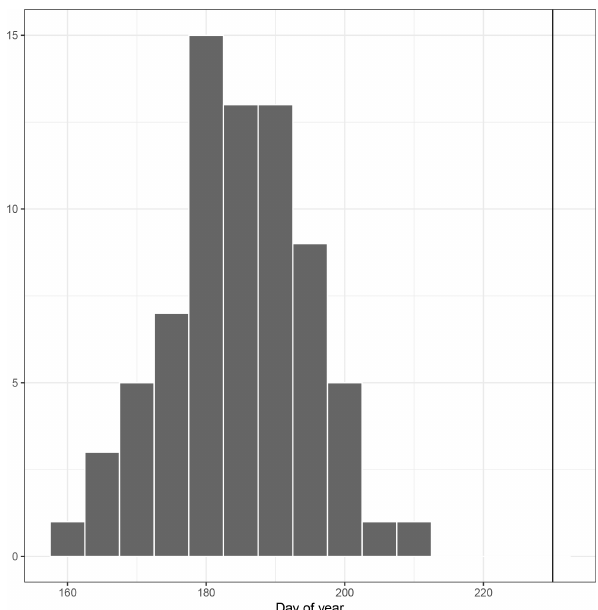
Figure 8. Histogram of expected first malaria symptoms in Rich- mond, Virginia, using data from 1942 to 2017. The black vertical line shows the median first malaria symptom reports in the data ex- tracted from the Shirley Plantation document covering the period 1822–1838.